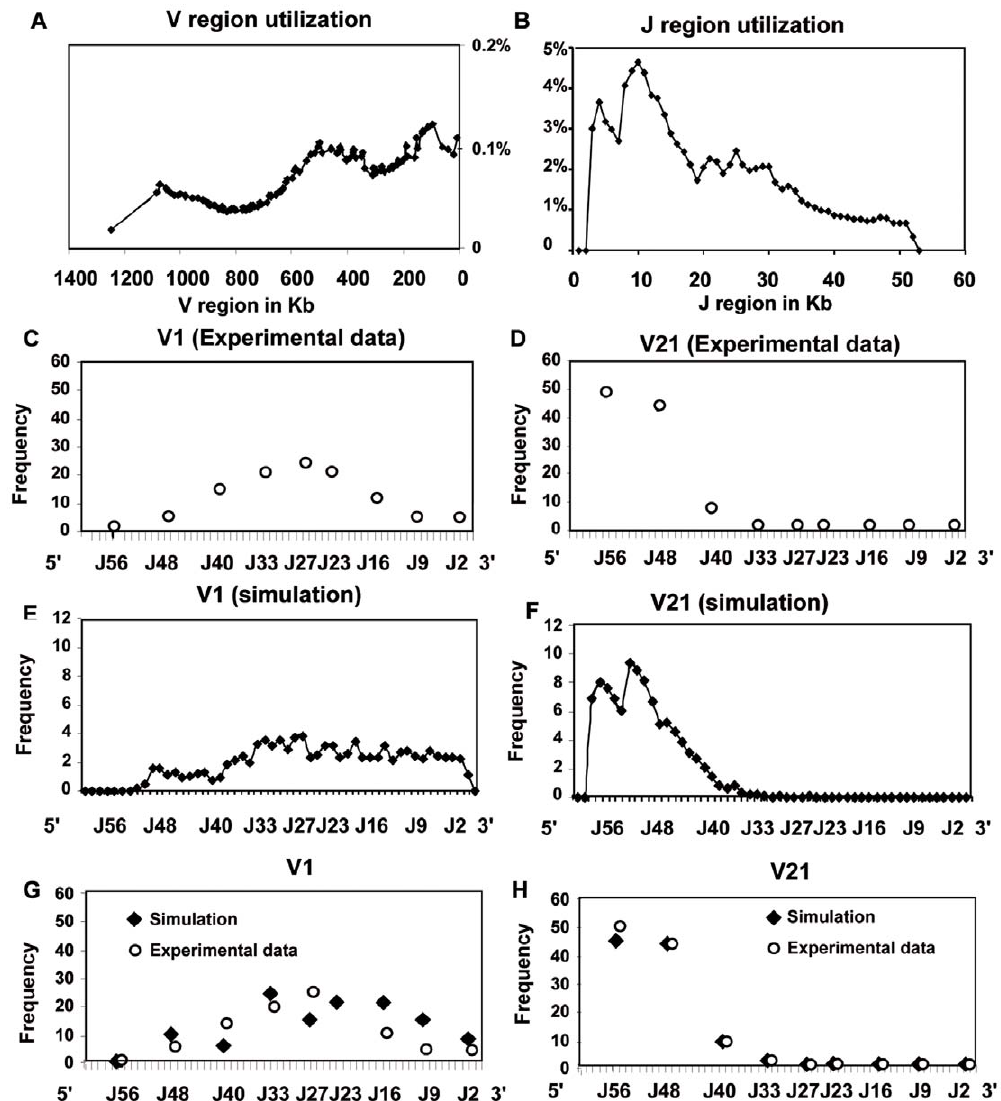
Figure 2. Validation of the modelling approach: analysis of the V and J region uses. (A) V region utilization: the X axis represents the V region in Kb. The Y axis shows the V gene percentage utilization in simulation. The simulated data sets have been normalized in order to be compared according to the following formula X ~ x { average ð Þ = Std deviation : The fixed parameters of the simulation were as follow, one million of alpha chains, ongoing 1 to 4 rearrangements with opening speeds of 18 Kb/h and 1.03 Kb/h for the V and the J region respectively; (B) J region utilization: the X axis represents the J region in Kb; (C) and (D) Amplitude of J region utilization by opposite V genes, V1 (distal) and V21 (proximal). The X axis represents experimental quantification on 9 J genes. The Y axis shows the experimental utilization frequency of 9 J genes by the V1 and V21 genes. (E) and (F) Amplitude of J region utilization in the model. The X axis represents the J genes. The Y axis shows the model frequency utilization by each J genes. (G) and (H) Superposition of experimental and simulated data for the 9 J genes. The X axis represents experimental quantification on 9 J genes. V and J regions utilization from simulated data are similar to experimental data obtained from [9]. combinations with J23 to J1 represent 17% and 15% of experimental and simulated data respectively. Noticeably, when the sums of simulated rearrangements are extended to all V, the uses of the J localized in the proximal, central and distal parts of the locus are in the same range than those found with V14 genes (last column of the Table 3). Additionally, the J use by the whole V14 family (Fig. 4 A) from our simulated repertoire presents a distribution where two Hot Spots are clearly visible. These Hot Spots are in accordance with our own observation from peripheral T-lymphocytes (Fig. 1 A) and the experimental data of Rytkonen et al [3,23].